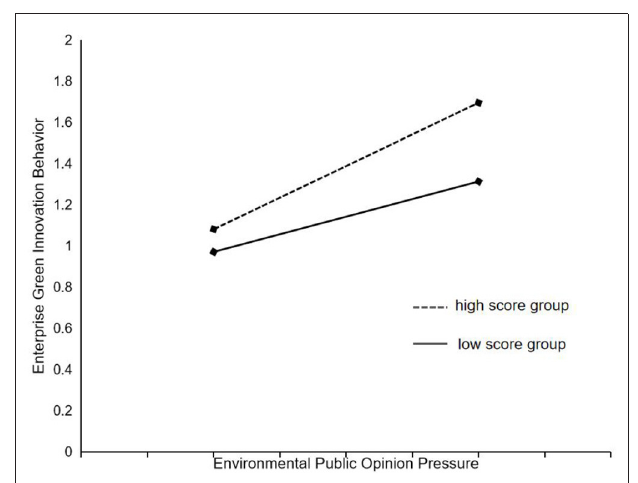
FIGURE 4 | The moderating effect of mandatory environmental regulation.